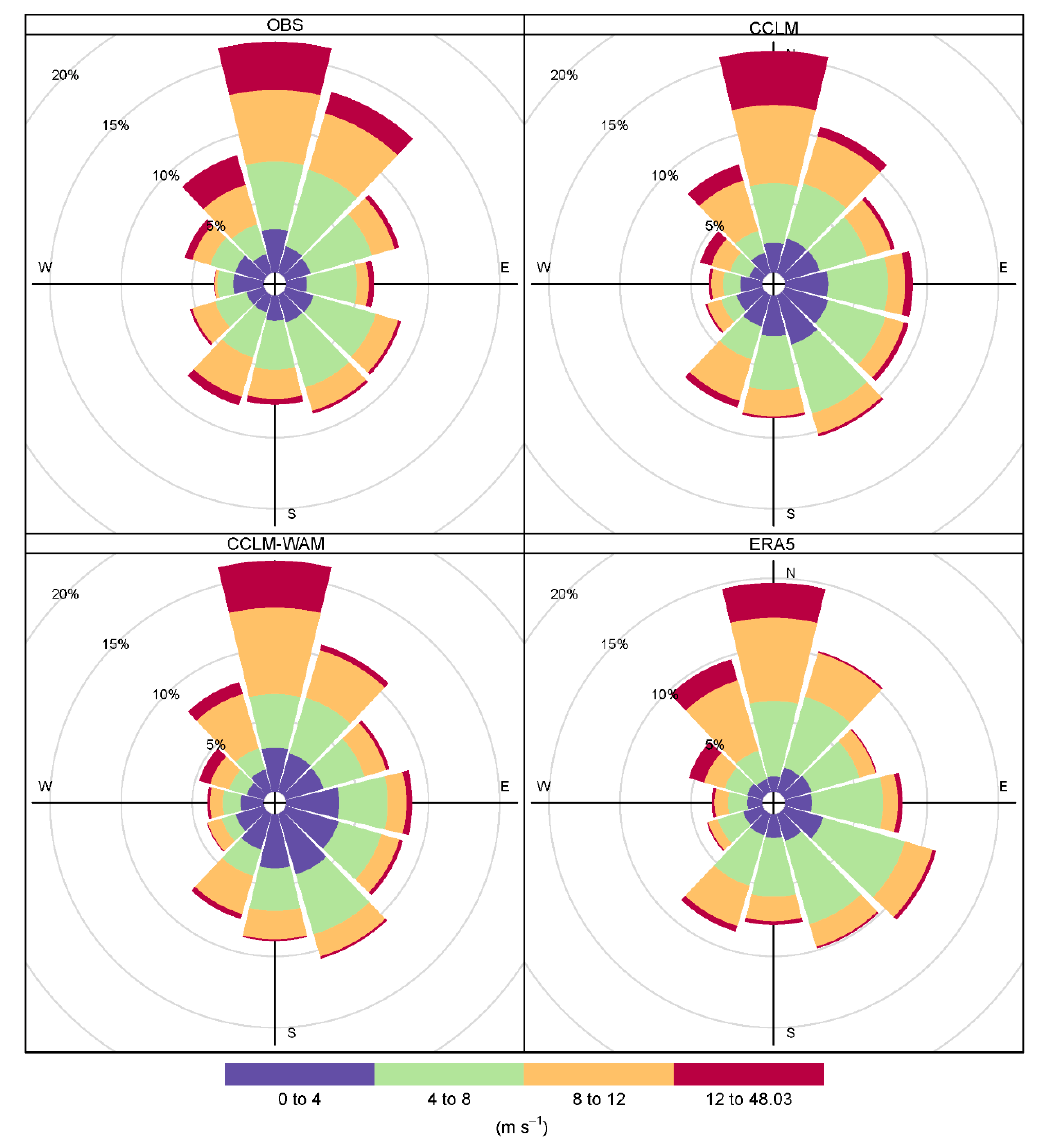
Figure 4. Wind rose diagrams at station IEODO for observations and modeled results. The wind direction interval is 30°.